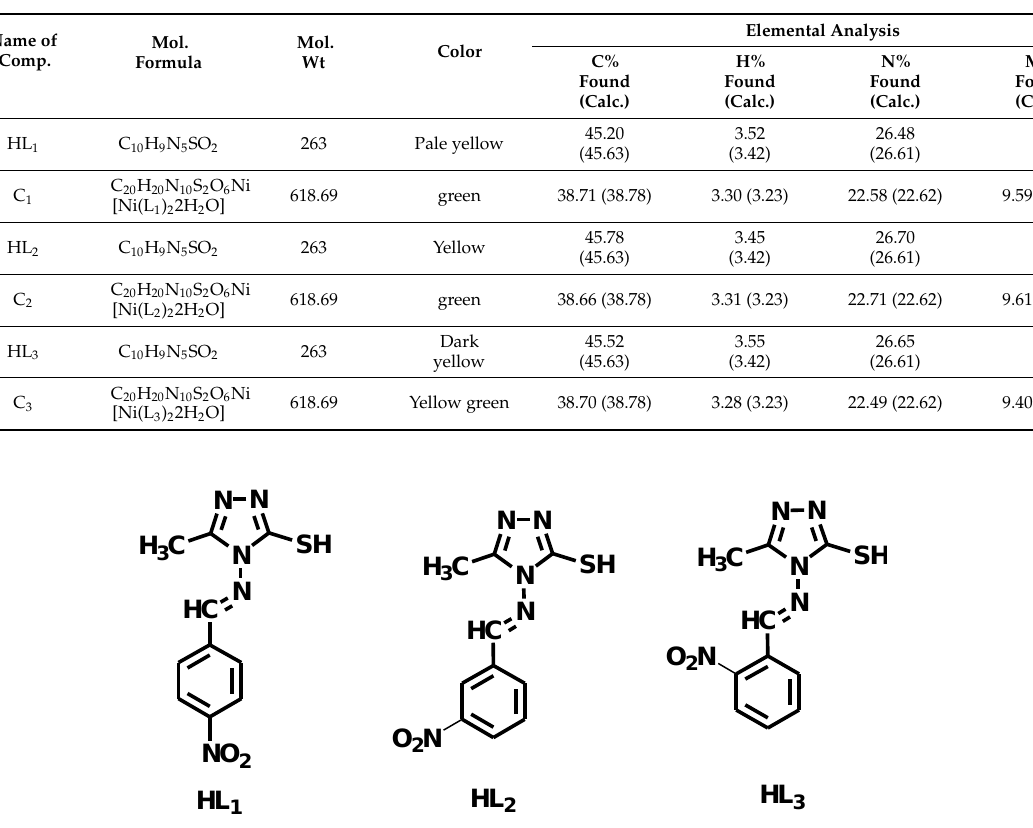
Table 1. Physical and analytical data of ligands and metal complexes.